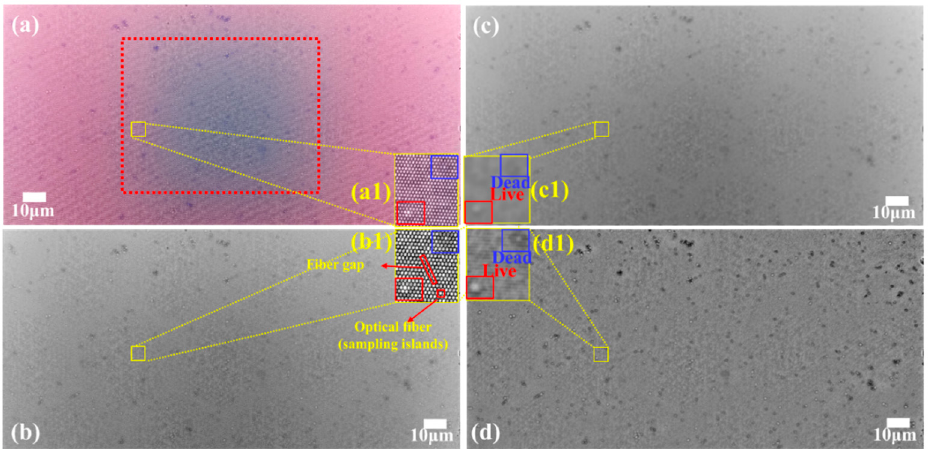
Figure 3. Yeast activity and concentration detection. ( a ) The original yeast image obtained by the FOA microscope; ( b ) the corresponding grayscale image. ( c ) The grayscale image processed by average filtering (radius = 5); ( d ) the grayscale image after AHE processing. The yellow label indicates the optical fiber gaps.